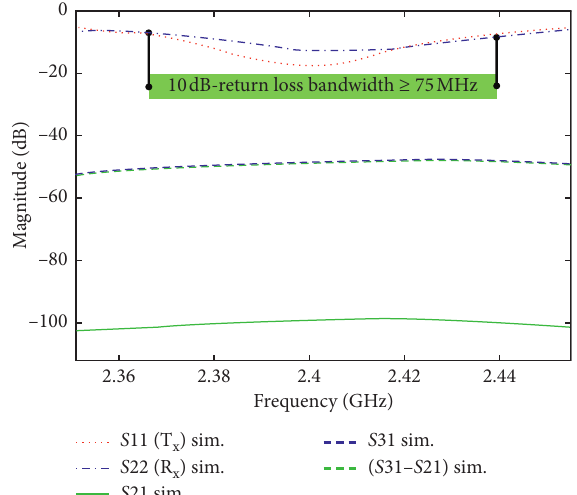
Figure 4: The simulated S -parameters for proposed bistatic an- tenna system having single port T x patch and dual port R x